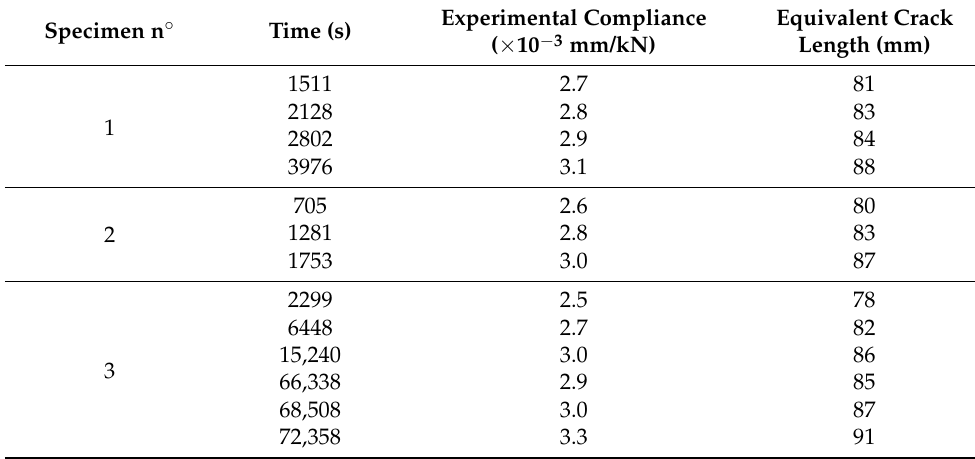
Table 2. Equivalent crack length versus experimental compliance for each test. Specimen n